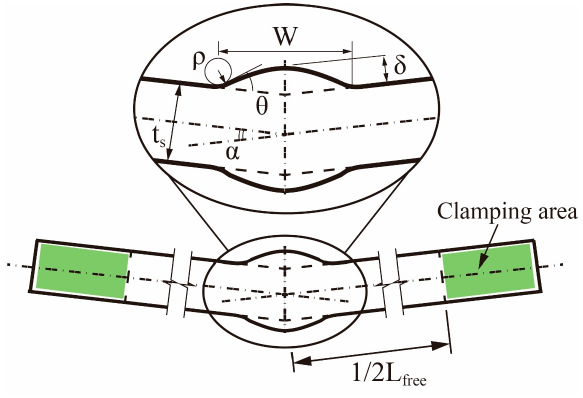
Figure 2. Parameter definition of distorted butt-welded joints under fatigue test conditions.